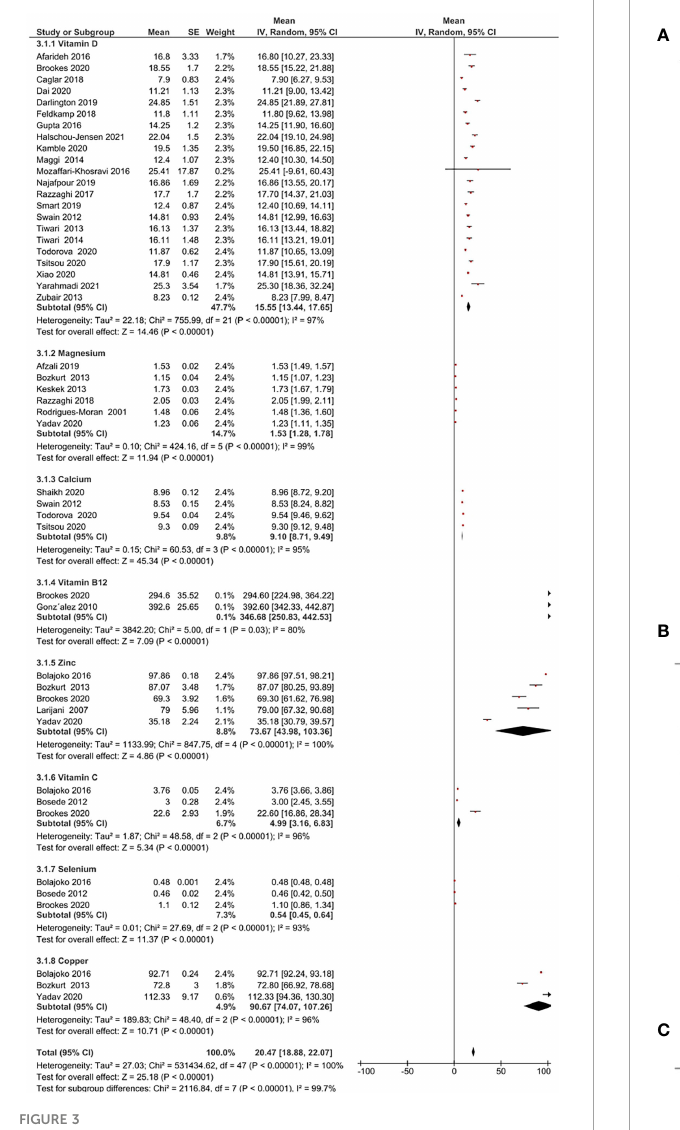
FIGURE 3 Summary of micronutrient levels in DFU patients. Forest plot of mean micronutrient status in DFU